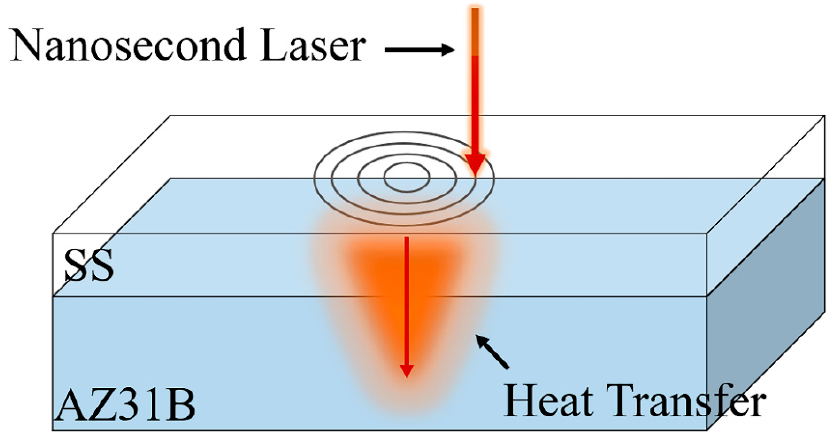
Figure 1. Schematic diagram of the laser welding. Table 3. Nanosecond pulse laser welding parameters.